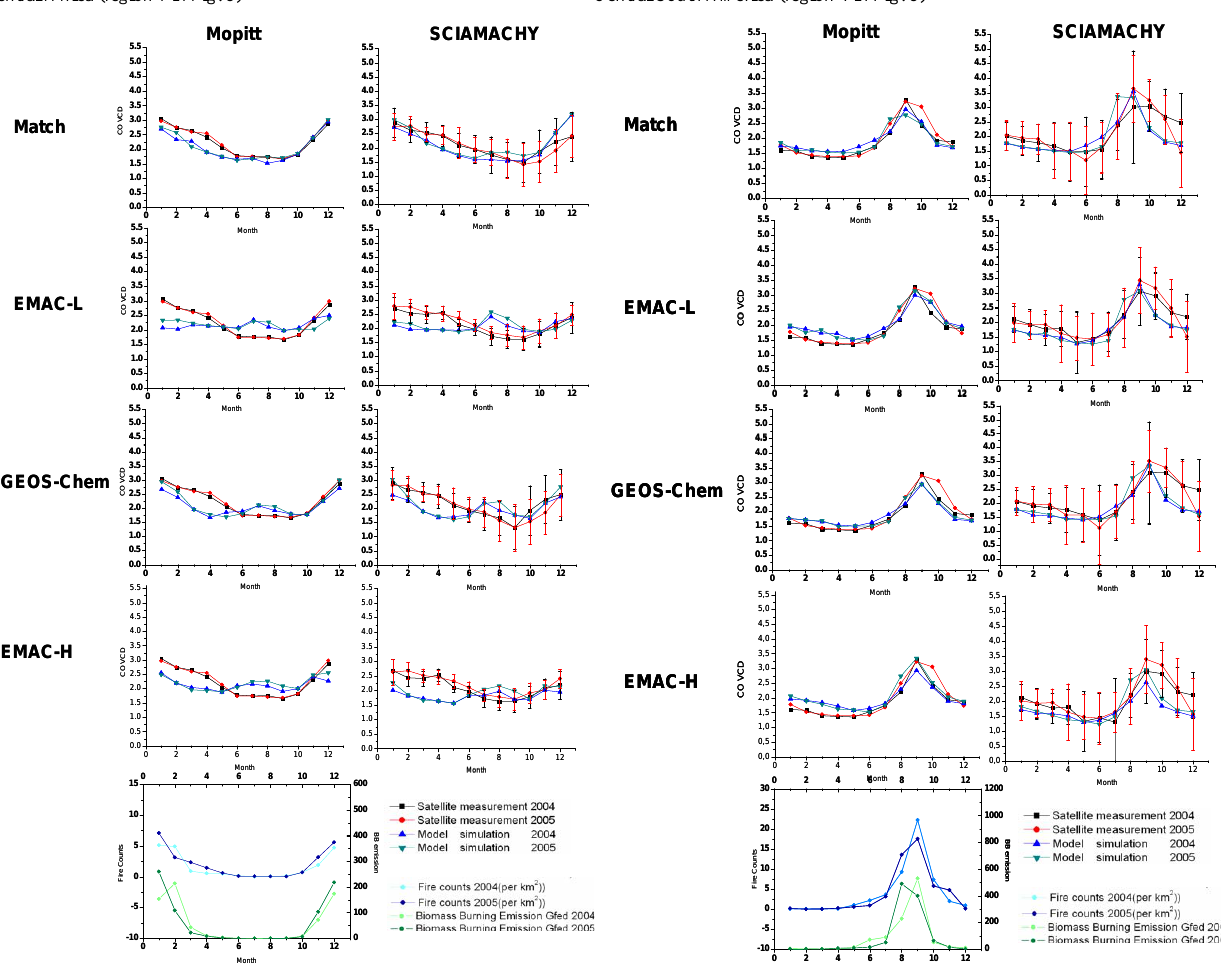
Fig. 13. Comparison of the monthly mean CO VCDs (in units of 10 18 moleccm − 2 ) between the satellite measurements (left: MOPITT; right: SCIAMACHY) and model simulations for three of the regions indicated in Fig. 8 (similar comparisons for the other regions indicated in Fig. 8 are shown in Fig. A6 in the appendix). All comparisons are done for only collocated measurements/model results; also the specific sensitivities of the satellite instrument have been considered (see text). In the bottom row fire counts from ATSR (in units of 10 − 4 perkm 2 per month), and GFED emissions used in the models (in units of 10 13 moleculescm − 2 s − 1 ) are shown. The error bar of SCIAMACHY refers to the unbiased estimator of a weighted population variance. EMAC-L refers to low (T42) and EMAC-H to high (T106) spatial